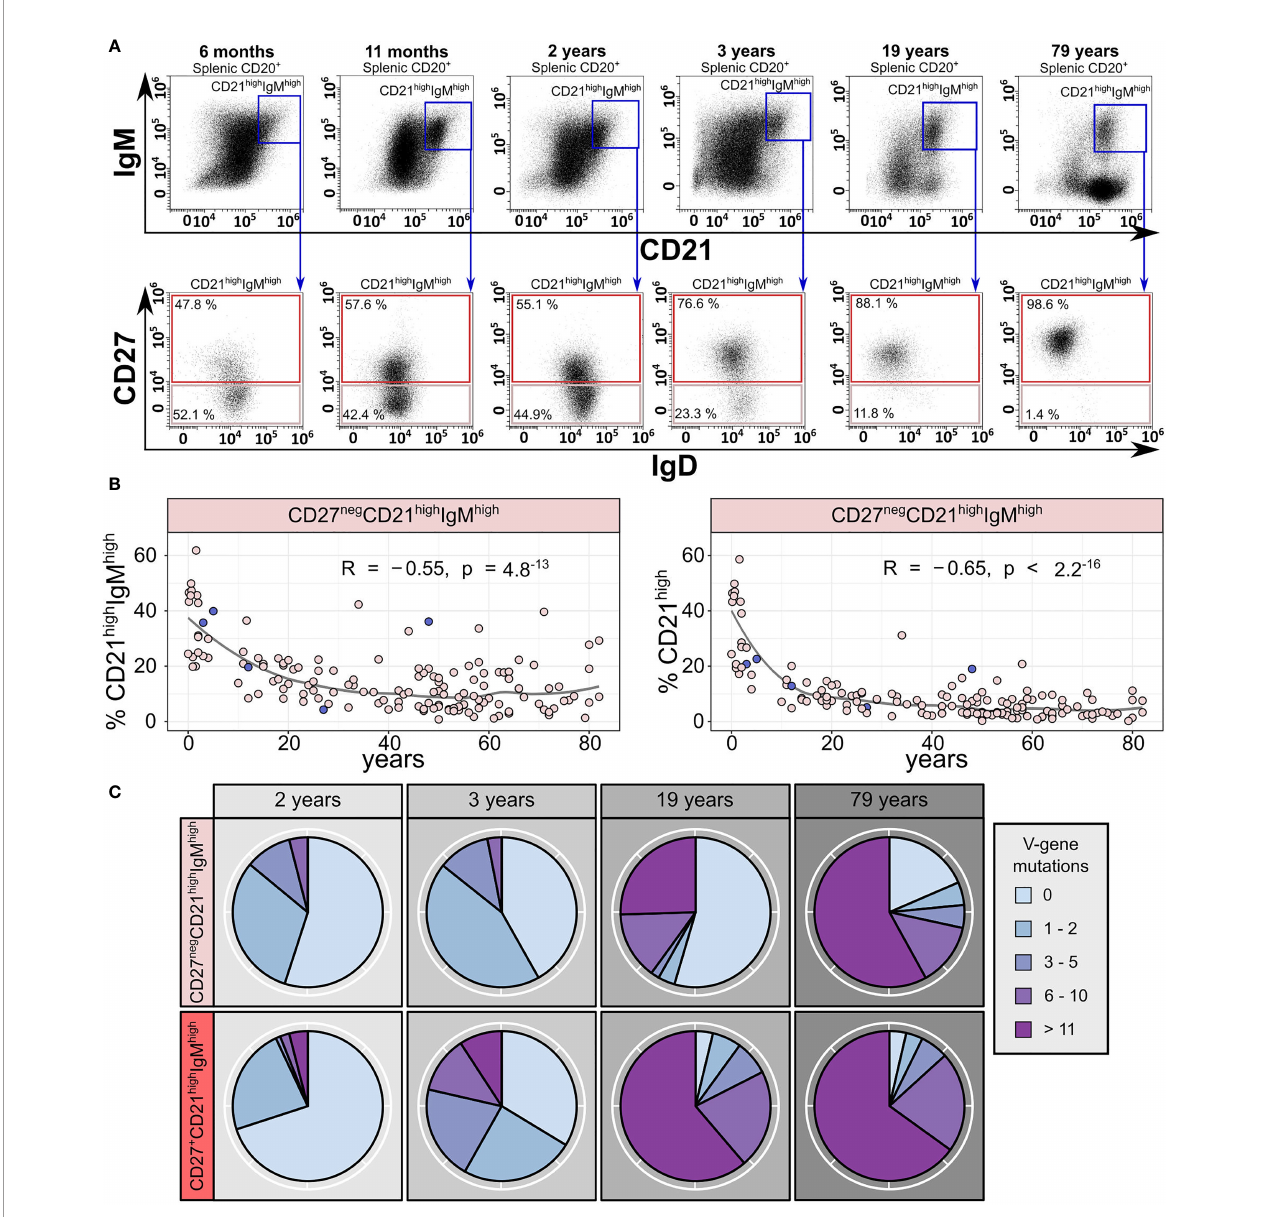
FIGURE 2 | Two subsets of human splenic CD21 high IgM high zone B cells exist, and their abundance changes with age. (A) Representative gating strategy of CD27 neg CD21 high IgM high and CD27 + CD21 high IgM high sMZ B cells from six donors (6 months, 11 months, 2 years, 3 years, 19 years, and 79 years). (B) Age-related frequency of splenic CD27 neg CD21 high IgM high B cells among IgM-expressing (left panel) and total sMZ B cells (right panel; n = 147; 104 donors originally published in Kibler et al. (8); 43 additional donors). The circles corresponding to the fi ve donors used for Fluidigm 96.96 analysis are marked in dark blue. Statistics denote Pearson ’ s correlation coef fi cient. (C) Number of IGHV gene mutations per IGHV sequence in CD27 neg CD21 high IgM high and CD27 + CD21 high IgM high B cells from four donors (2 years, 3 years, 19 years, and 79